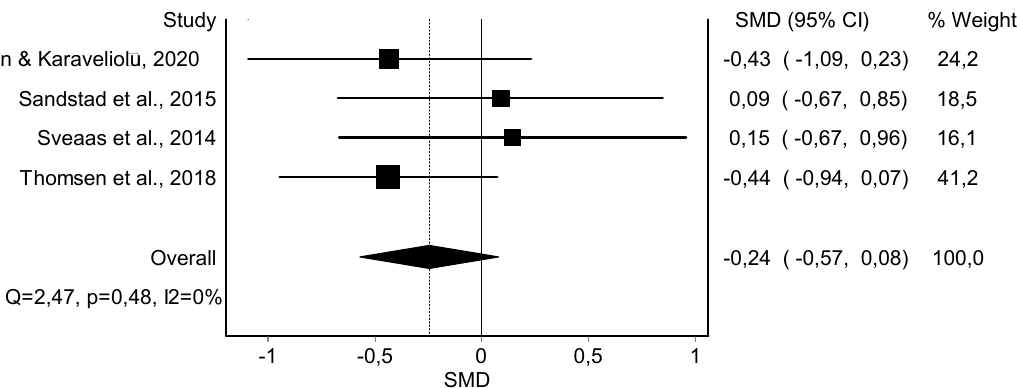
Figure A7. Synthesis funnel and Doi plot (LFK index) for body weight.